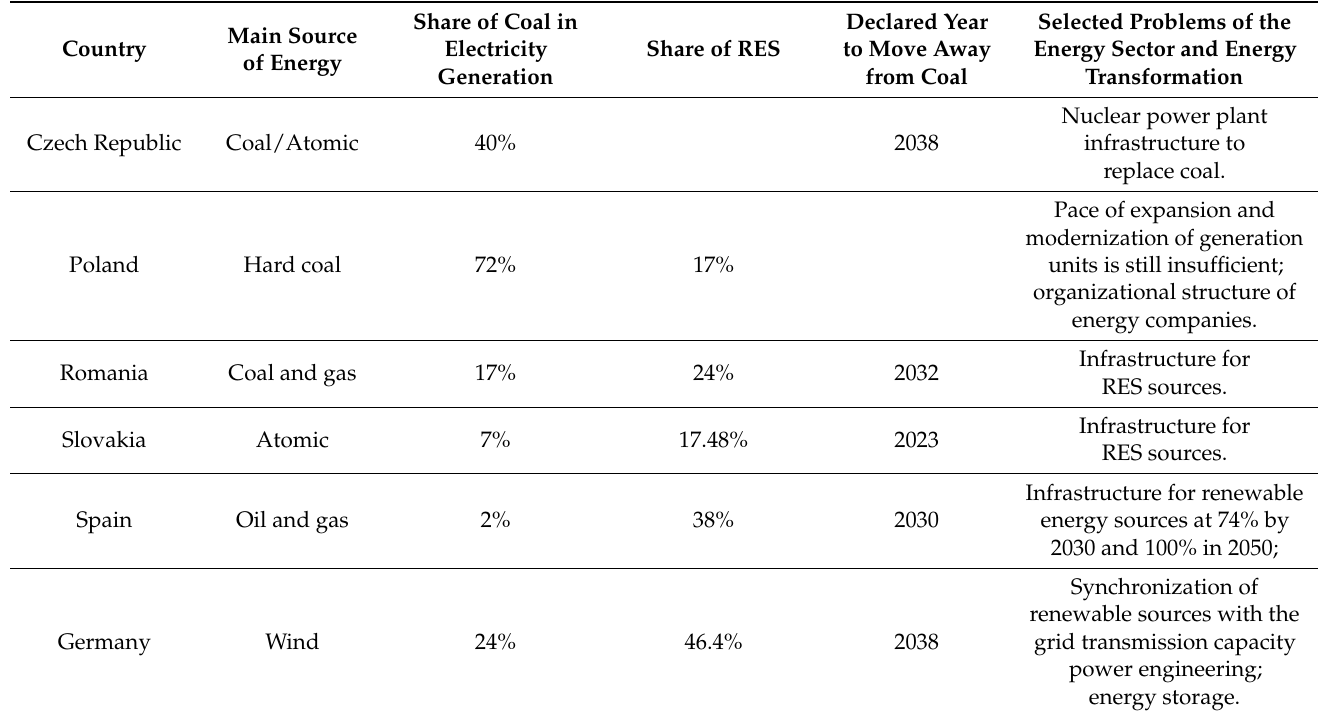
Table 1. Selected information on the energy sector in different countries and the challenges involved (source: own elaboration, based on